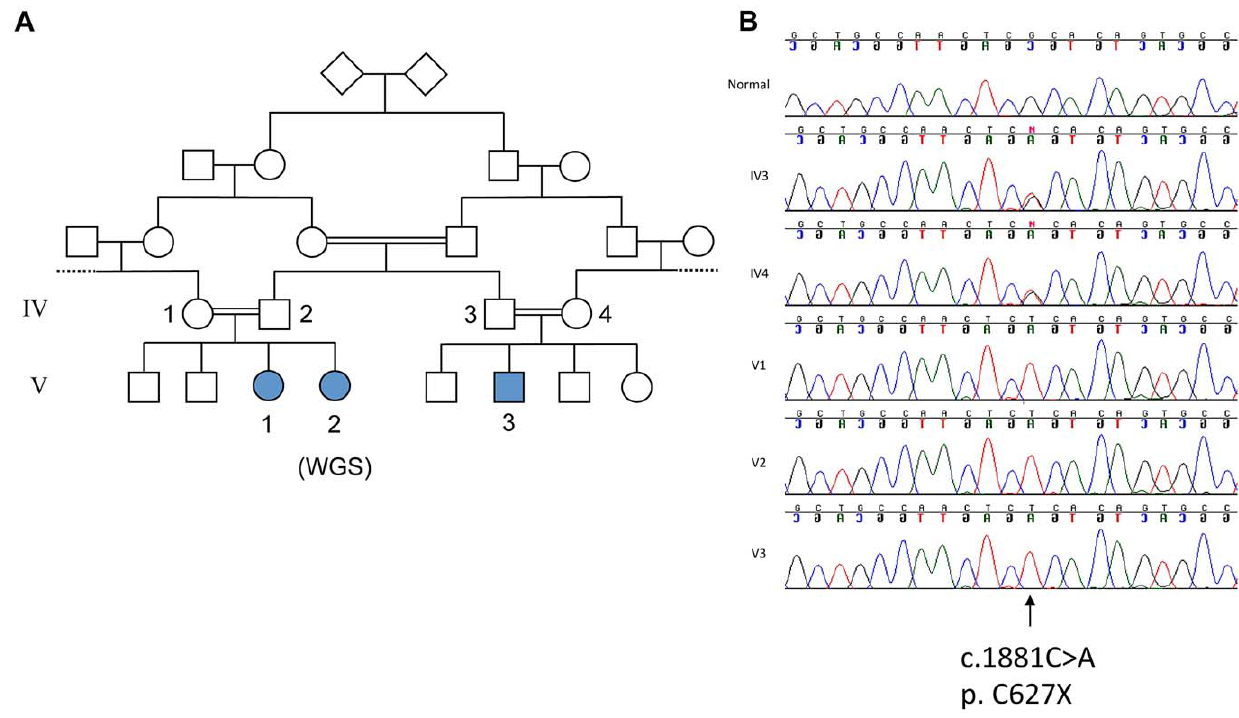
Figure 1. Genetic analysis of family with ataxia and cognitive impairment. A. Pedigree of family. B. Sanger sequencing of the mutation c. 1881C . A; p.C627X in normal, parents of V3 (IV3 and IV4) and affecteds, V1, V2, V3.